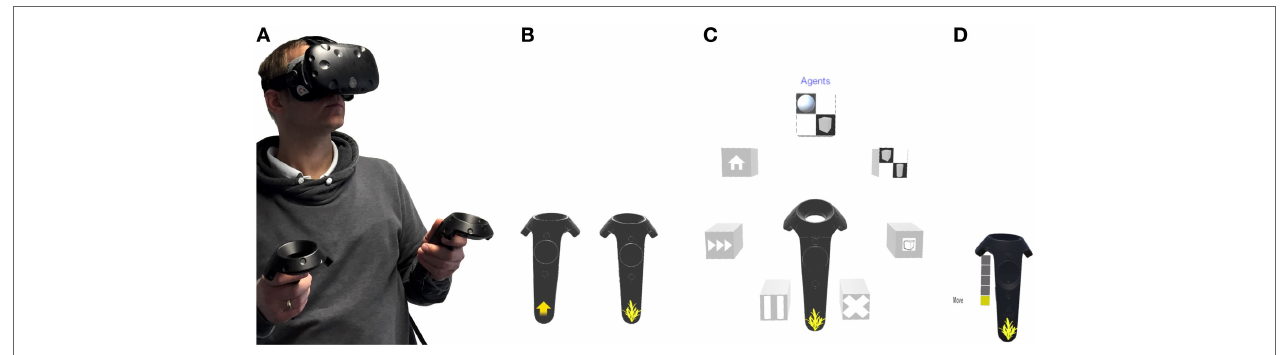
FigUre 10 | (a) The virtual reality gear consists of a head-mounted display and two handheld 3D controllers. (B) Each controller is assigned with disjunct subsets of control features (left: locomotion, right: construction and control of the virtual world and agents). (c) A radial menu offers multiple interaction